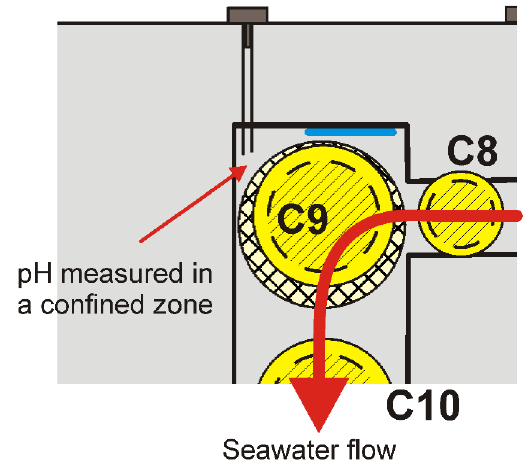
Figure 4. Schematic representation of the channel around coupon C9. The blue line corresponds to the Ag/AgCl microelectrode. The large bended red arrow displays (schematically) the water flow. The pH was monitored all along the experiment (approximately every two